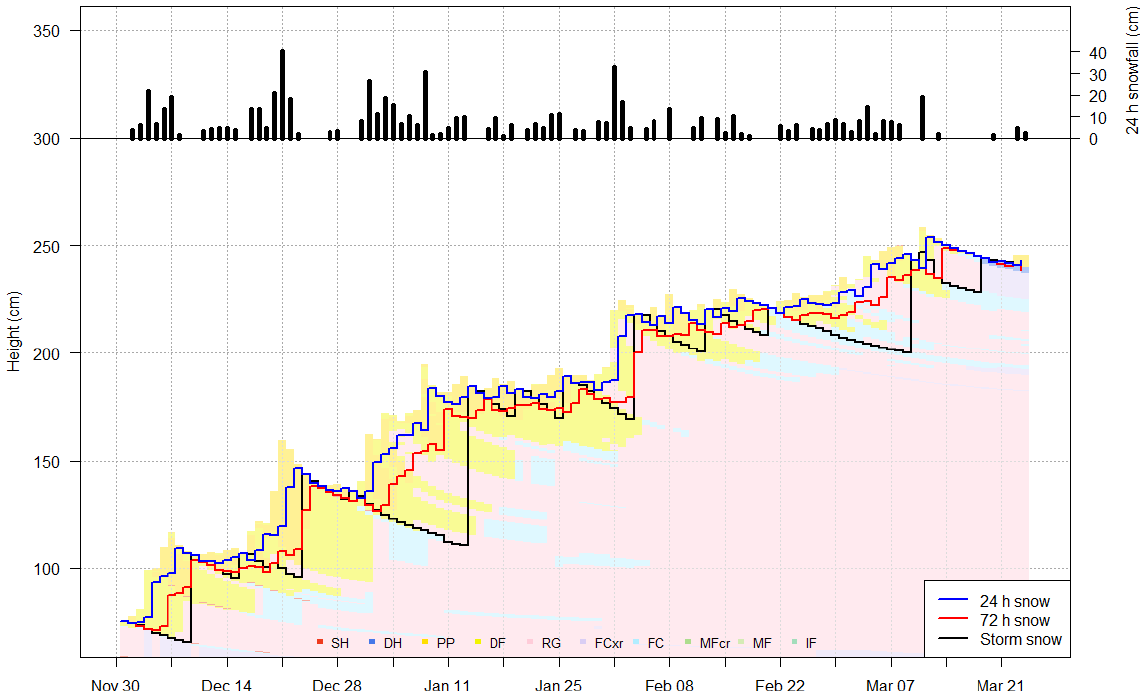
Figure 2. Daily snowfall amounts and snowpack interfaces identified in the upper snowpack for the 2019–2020 treeline profiles. Interfaces include all snow deposited in the past 24h and 72h and since the last day without snow. Bars show the modelled height of new snow every 24h.